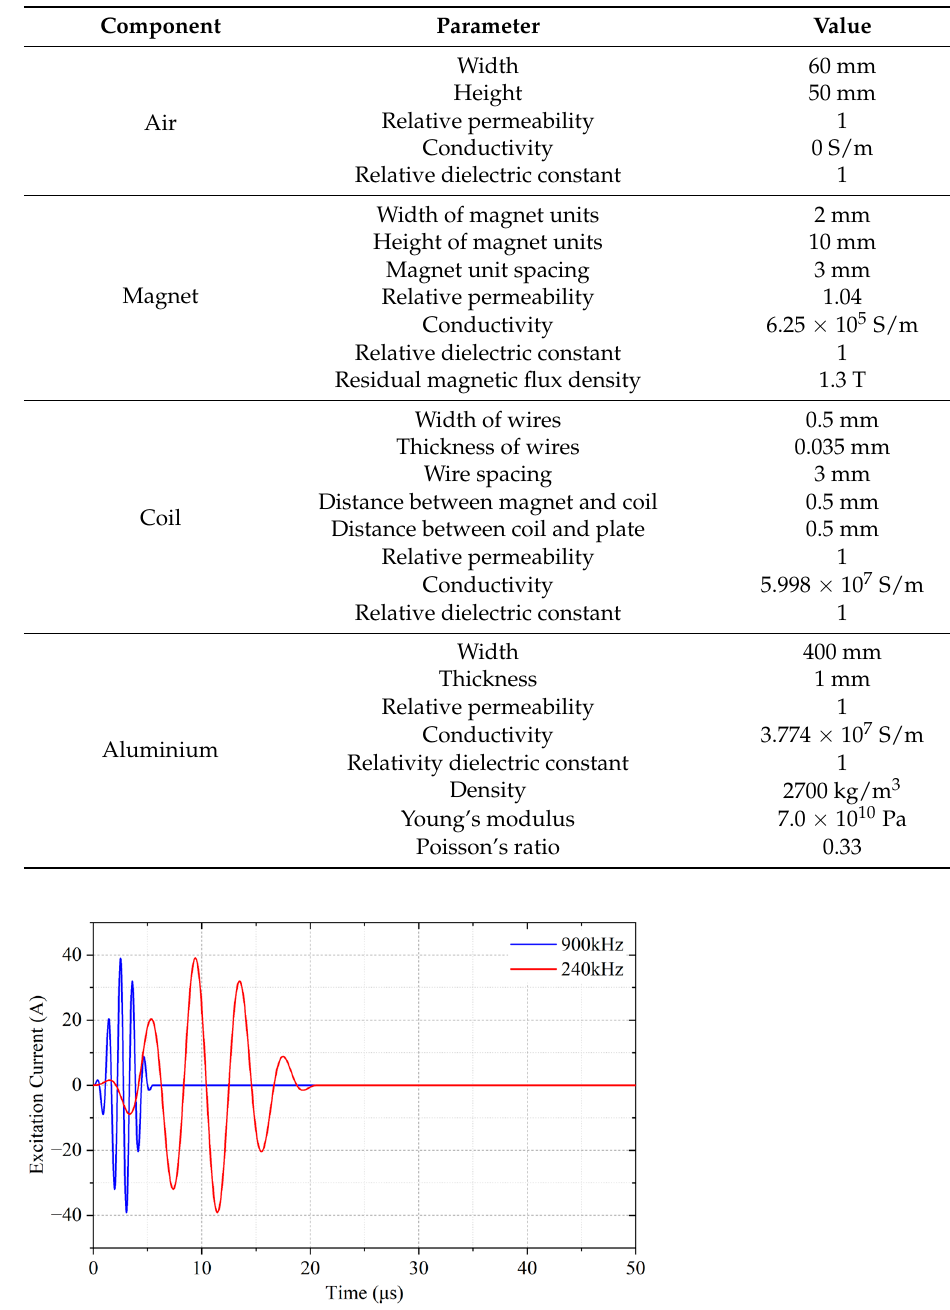
Table 1. Geometric and physical parameters of simulation models.